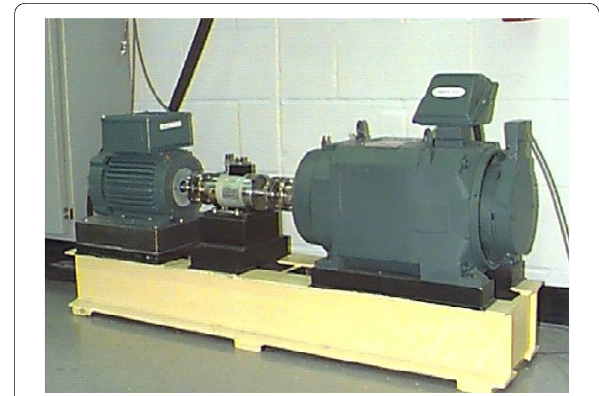
Figure 5 Bearing test bench